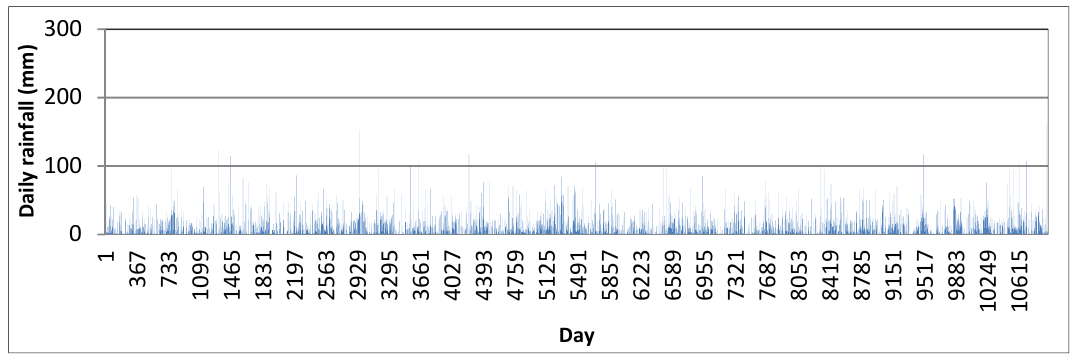
Figure 4. Daily rainfall for Santarém, Brazil, for a 30-year time series.